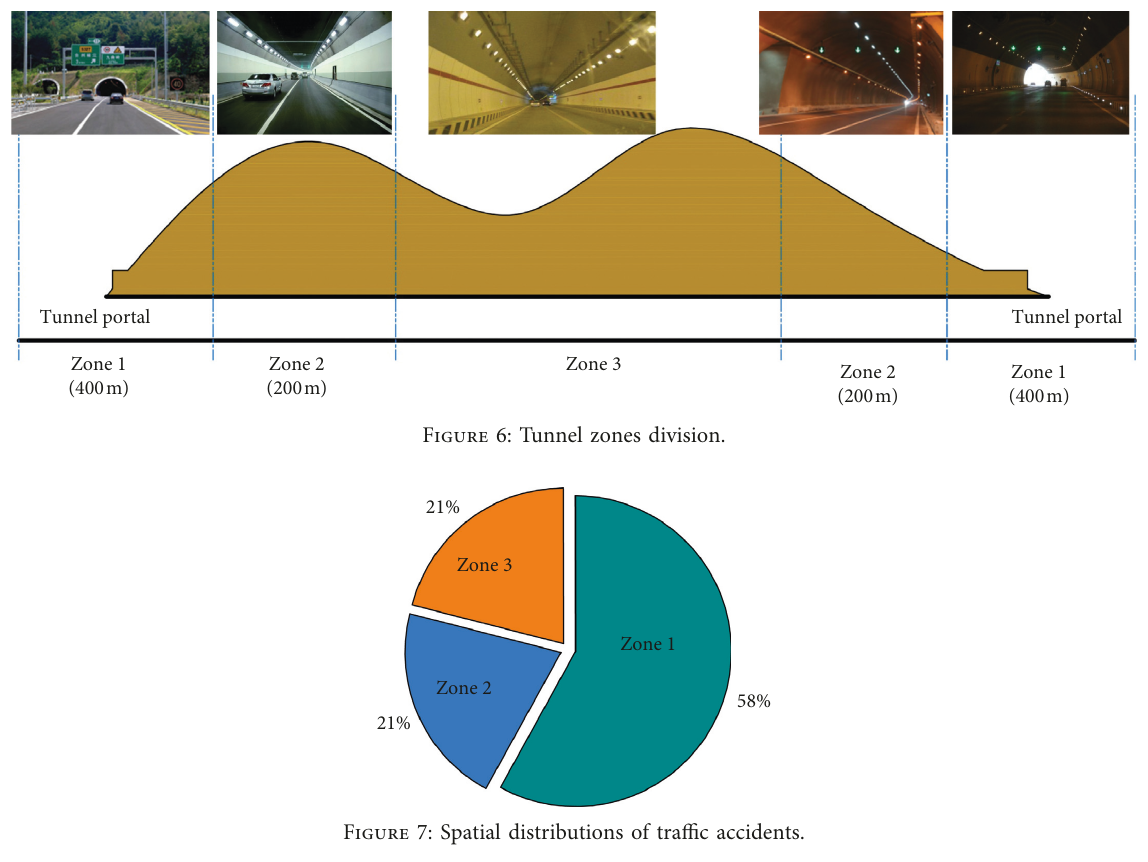
Figure 7: Spatial distributions of traffic accidents.